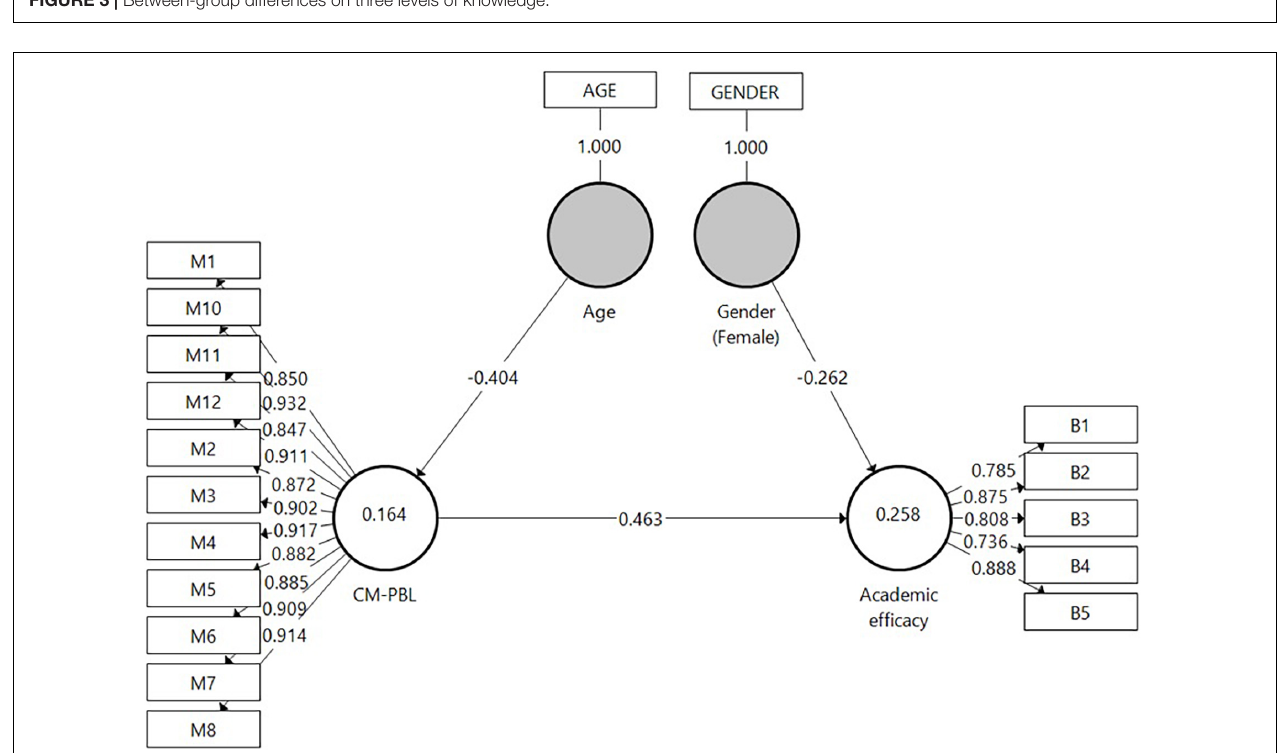
FIGURE 3 | Between-group differences on three levels of knowledge.